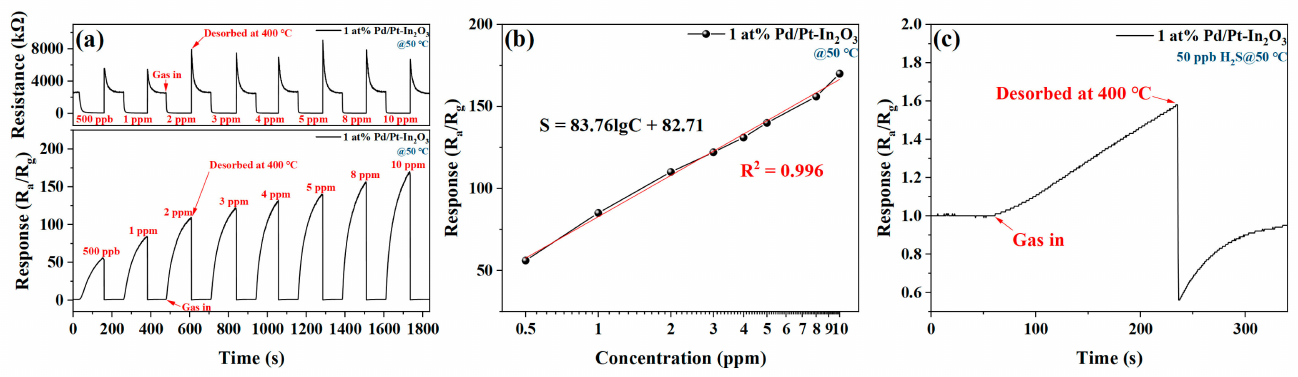
Figure 7. ( a ) Dynamic change in resistance and response of 1 at% Pd/Pt-In 2 O 3 to different concentra- tions of H 2 S (500 ppb–10 ppm) at 50 ◦ C. ( b ) Relationship between the response of 1 at% Pd/Pt-In 2 O 3 and the concentration of H 2 S at 50 ◦ C. ( c ) Response of 1 at% Pd/Pt-In 2 O 3 to 50 ppb H 2 S at 50 ◦